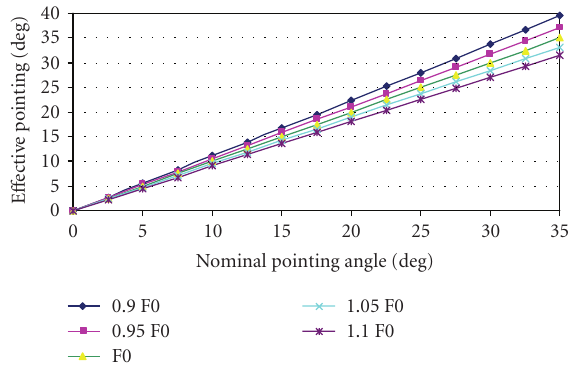
Figure 1: Beam pointing versus frequency in